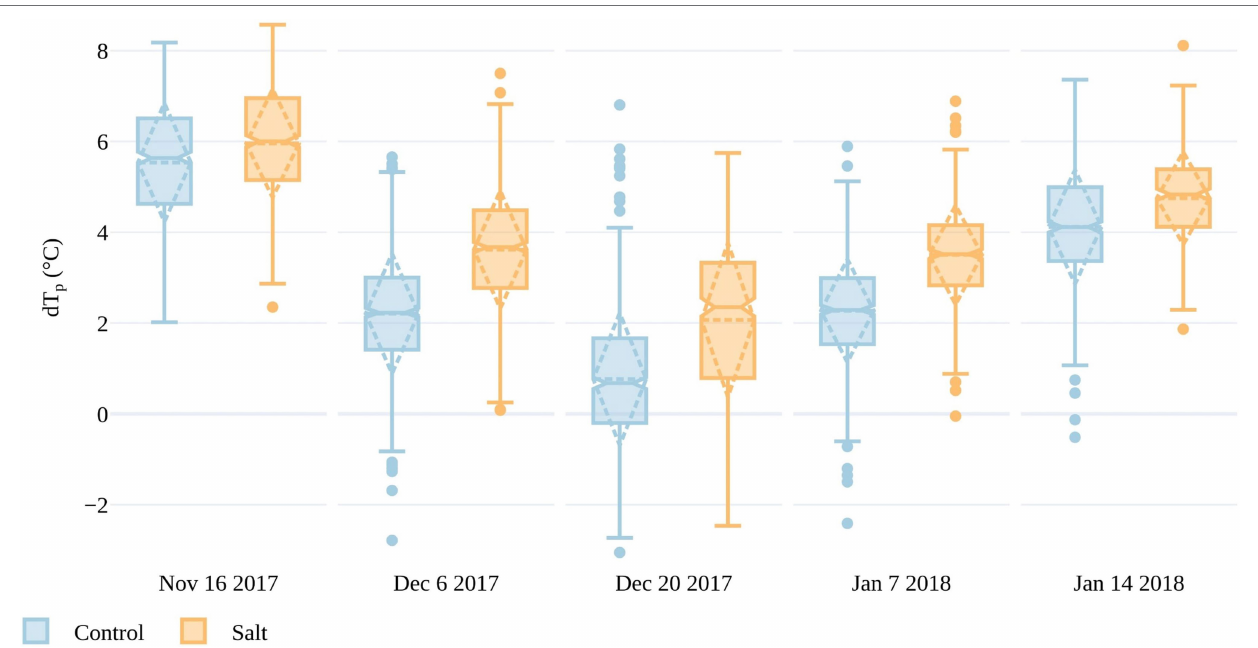
FIGURE 7 | Differences between plant and air temperatures (dT p ) for all plants within the salt and control plots for the five UAV campaigns. The boxes span the interquartile range (IQR), with notches indicating the median and the dashed diamond the standard deviation and mean. The whiskers bound